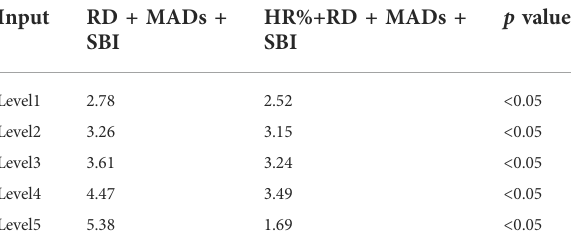
TABLE 7 Comparing the predicted result of different inputs in each level during Bruce treadmill test.